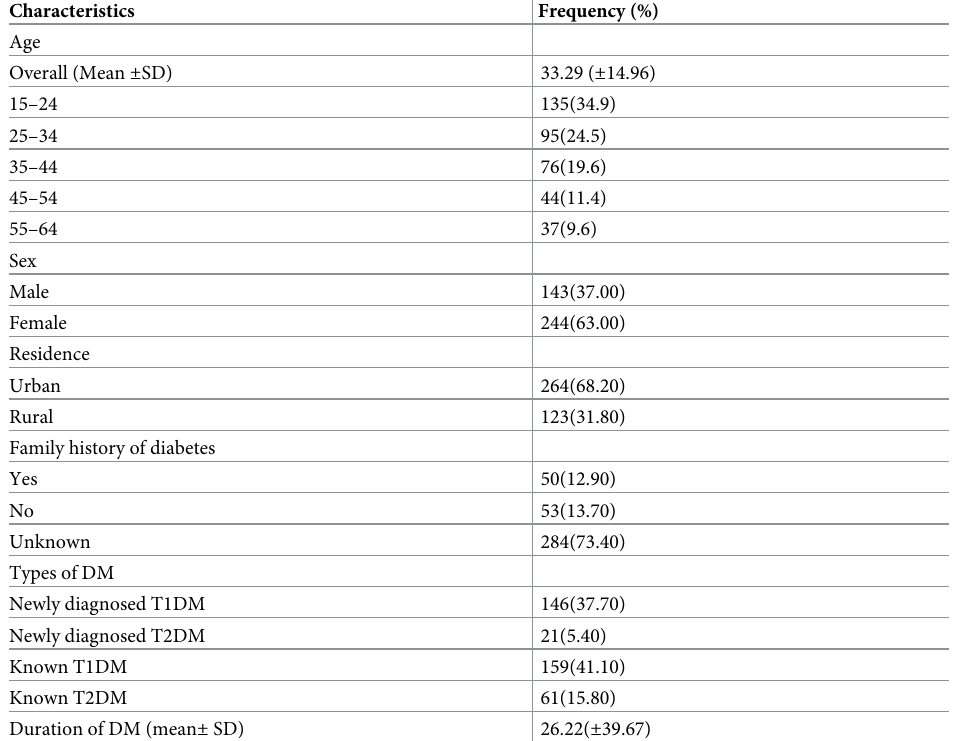
Table 1. Sociodemographic and disease status of DKA patients admitted at DTGH from August 2010 to May 31, 2018(n = 387).